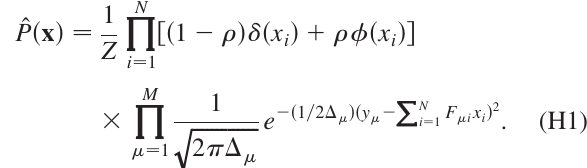
TABLE III. Mean-squared error obtained after reconstruction small amount of noise. As shown in Appendix B, the for the Shepp-Logan phantom image (top) and for the Lena probability of x after the measurement of y is given by minimization, BP, and s-BP. image (bottom), with ‘ 1